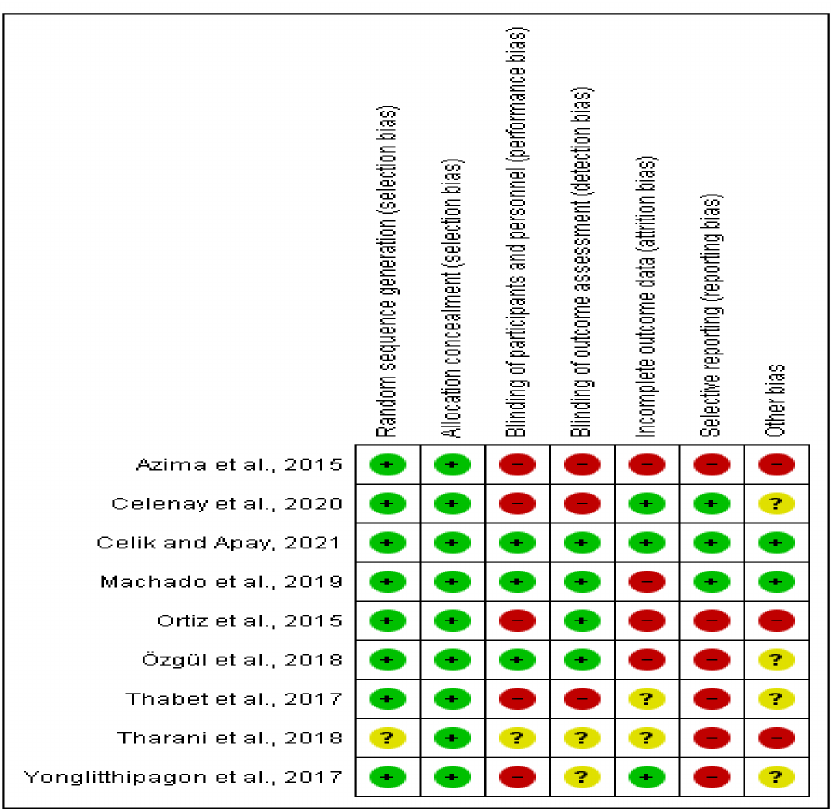
Figure 2. Summary of Risk of Bias in included